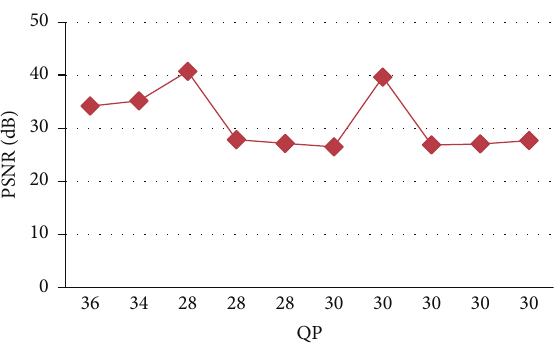
Figure 9: Evaluation of the LLA: impact of the Quantization Parameter (QP) on PSNR.